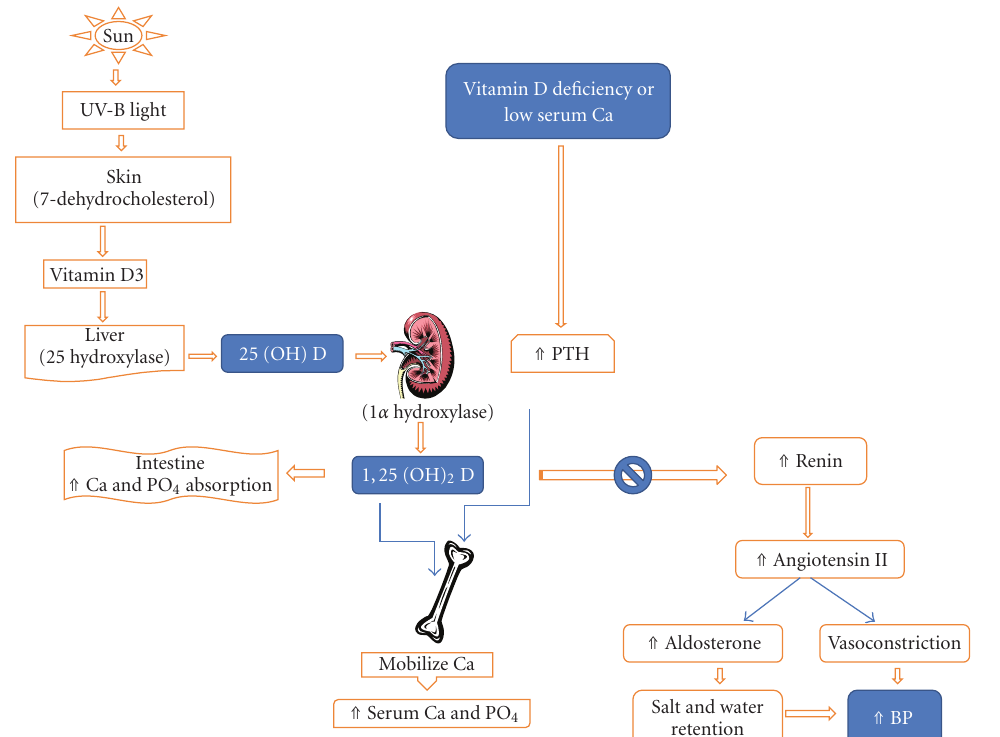
Figure 1: Pathway of vitamin D metabolism and its relationship with PTH and renin-angiotensin-aldosterone